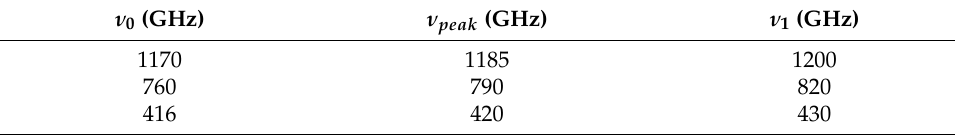
Table 2. Extracted frequency ranges based on the proposed